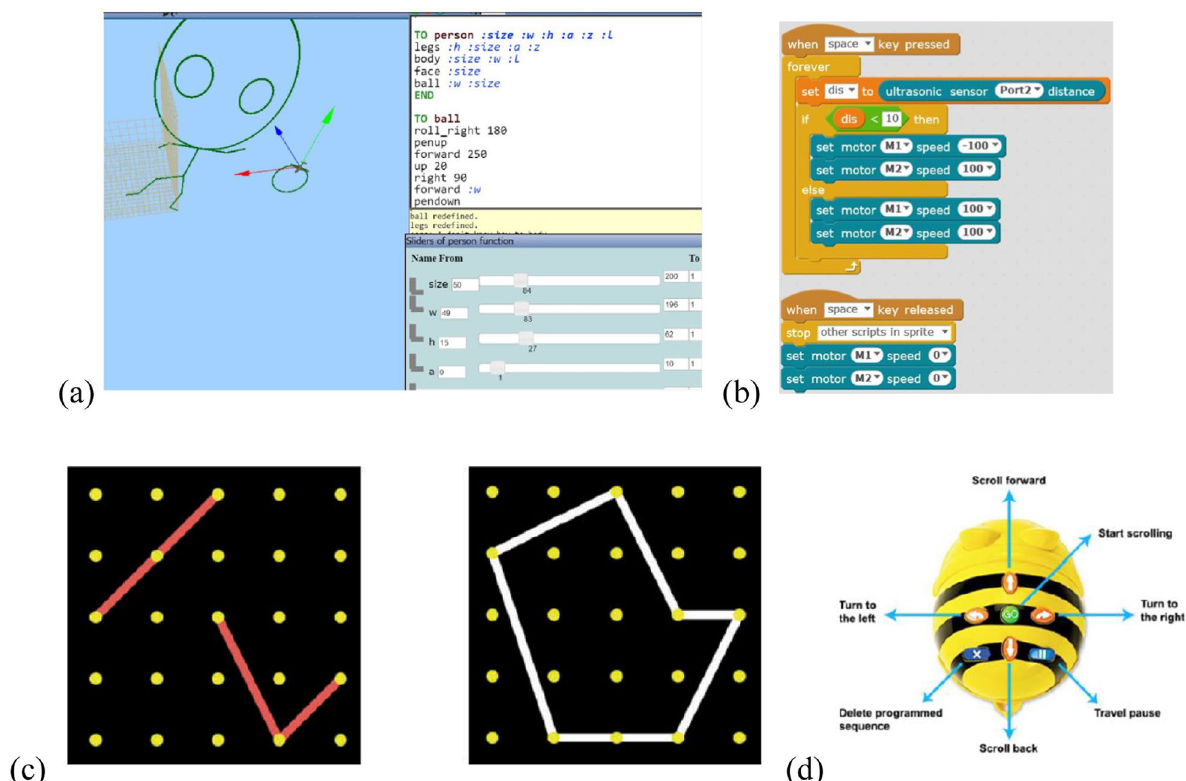
Fig. 4 a Interface of text‑based programming tool MaLT2 (Grizioti & Kynigos, 2021, p. 10); b a block‑based programming tool mBot (Sáez‑López et al., 2019, p. 1414); c segments and a polygon drawn in a geometrized programming tool Lattice Land (Pei et al., 2018, p. 78); d a Bee-bot robot , a form of tangible programming used in Muñoz et al., (2020, p.